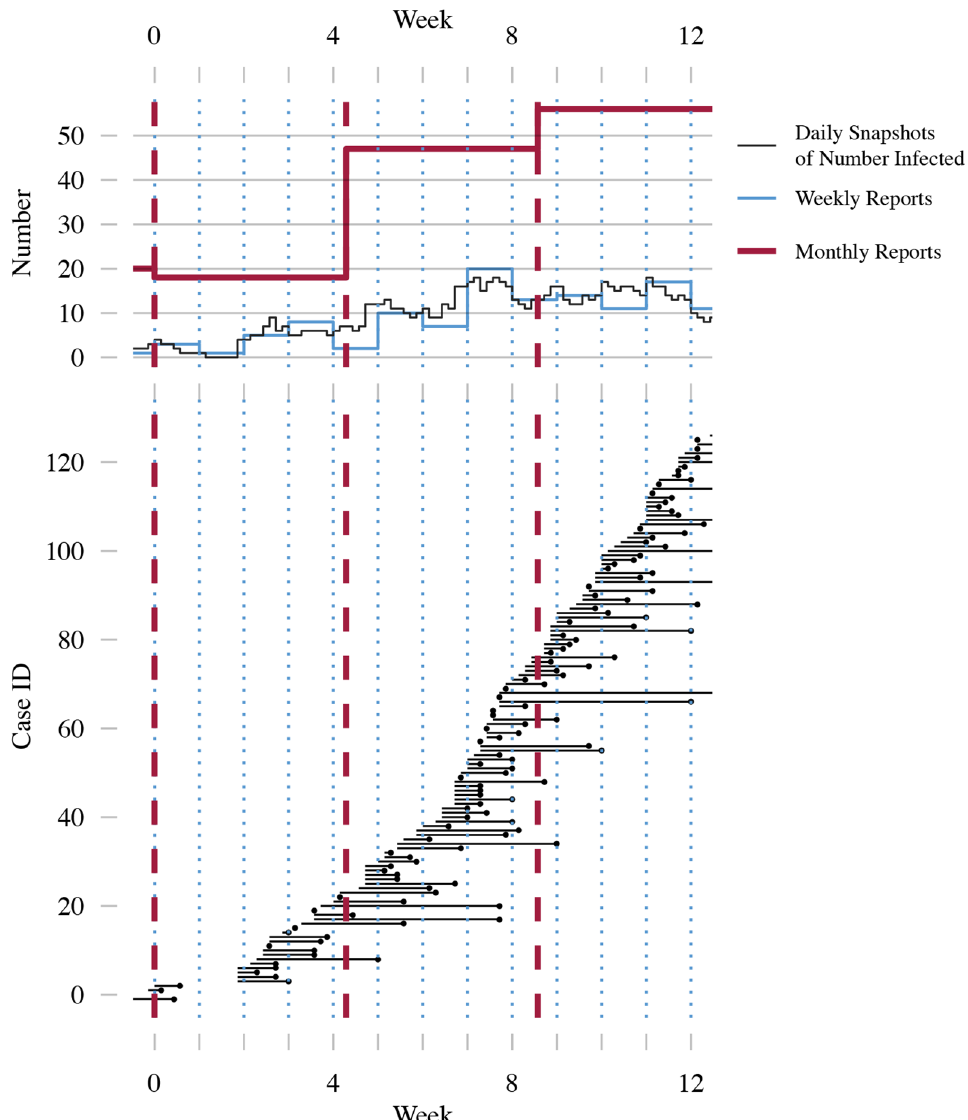
Fig 1. Demonstration of aggregation effects in epidemiological data. The bottom panel shows the progression of a simulated outbreak in a population, with cases ranked by their time of infection. Solid black lines indicate the duration of infectiousness, dots indicate time of recovery. The top panel shows three time series calculated from the simulated data: daily snapshots of the number of infected present in the population (black), weekly case reports (blue) and monthly case reports (red). For the purposes of this paper, the number of recovery events falling within an aggregation period serves as a proxy for the true number of cases in a case report. Aggregation periods are delimited by blue dots for weekly reports and red dashes for monthly reports. No reporting error is applied to the case reports shown in this figure. Transmission dynamics are modeled using the SIR model with birth and death with average population size N 0 = 10 6 , importation rate z = 1 case per week, mean life expectancy of 70 years, and mean infectious period of 1 week. R 0 increases linearly from 0 to 1 over 20 years. Simulations performed using the Gillespie algorithm